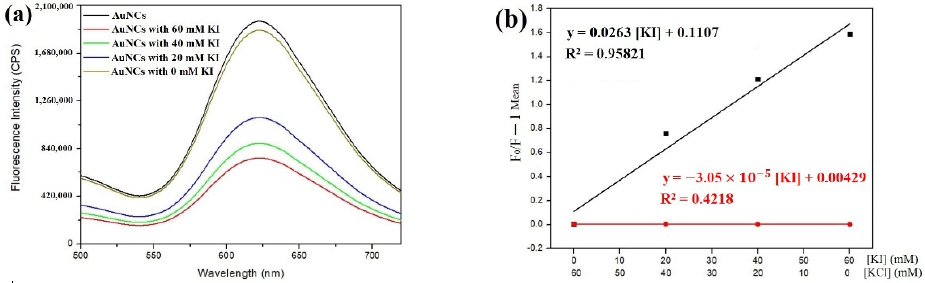
Figure 4. Iodide ions quenching glutathione-Au NCs. ( a ) The emission intensity of glutathione-Au NCs was quenched by the addition of iodide ions (KI). Chloride (KCl) was added to ensure that each sample had the same ionic strength, even though the concentration of iodide differed. Concentrations of total ions {[I − ] + [Cl − ]} are 60 mM. ( b ) The net fluorescence intensity obtained from each sample, which was titrated with 60 mM KCl, was designated F 0 , and the intensities of the other three samples were designated F. glutathione-Au NCs (black line), and DTT-Au NCs (red line).